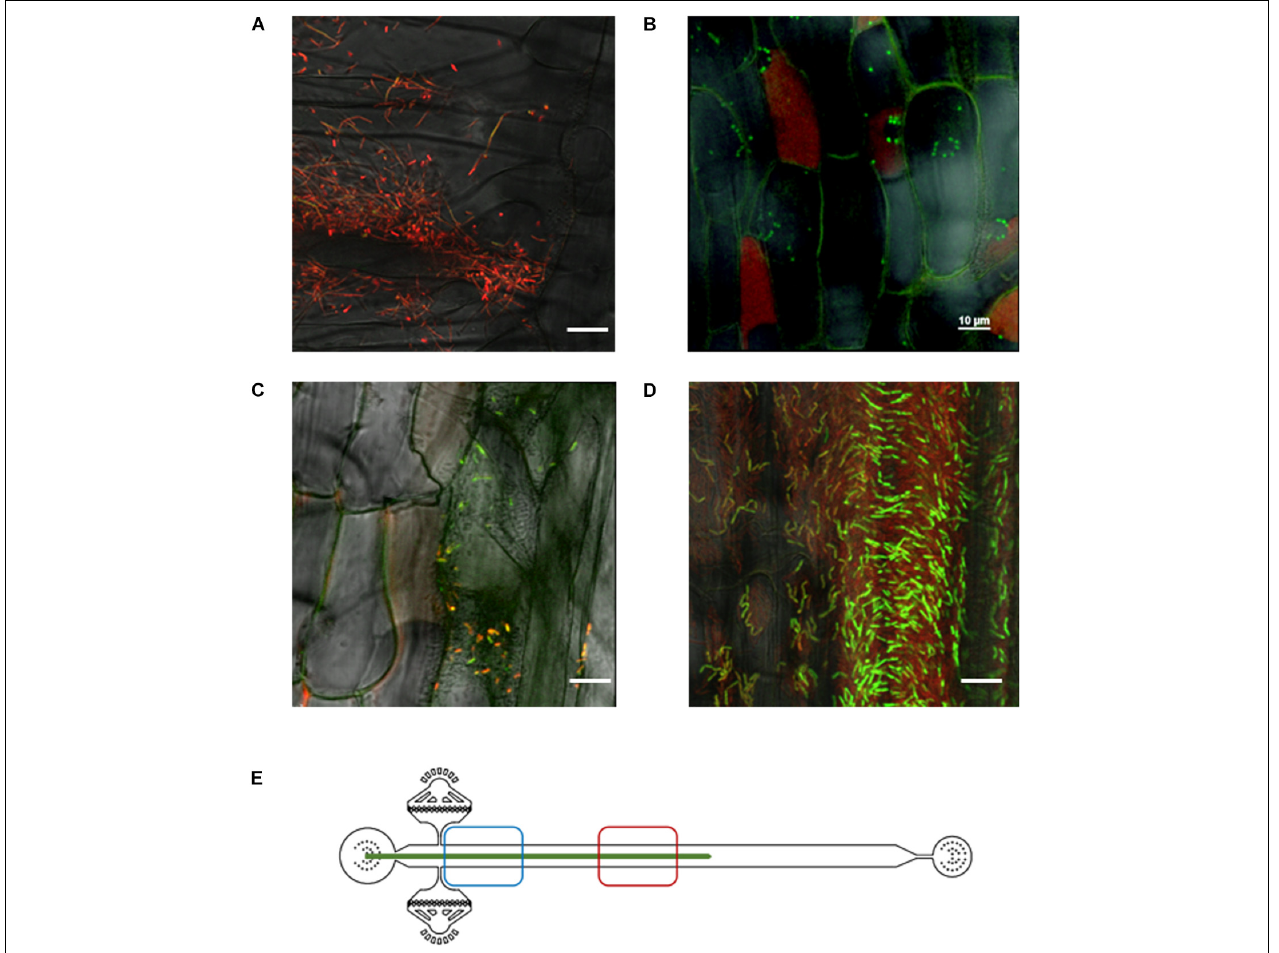
FIGURE 5 | Bacillus subtilis biosensors exposed to aspen root (A–C) and rice root (D) in the RMI-chip. (A) Among the root hairs, the xylose biosensor cells appear red from constitutive mCherry expression with a very faint GFP (green) signal detected in some cells. Similar results were obtained with the ROS biosensor (not shown). (B) Five days after inoculation, rare attached biosensor cells overwhelmingly express GFP, indicating the presence of xylose in root exudates. Note the plant tissue autofluorescence causing cell outlines to be green and some plant cells to be entirely red. (C) After 5 days, most of the rare ROS biosensor cells expressed GFP, indicating the presence of ROS produced by the root. Plant tissue autofluorescence is also detected. (D) Three days after inoculation of a rice seedling, the B. subtilis ROS biosensor displayed robust colonization of the root with a strong expression of GFP in a substantial fraction of the cell population, indicating production of ROS by the rice root. Scale bar indicates 10 µ m length. (E) Xylose- and ROS-sensing Bacillus cells in panels (B) and (C) were observed in the lower part of the aspen root (red square). ROS-sensing Bacillus cells on rice roots in panel (D) were observed in the upper part of the RMI-chip (blue